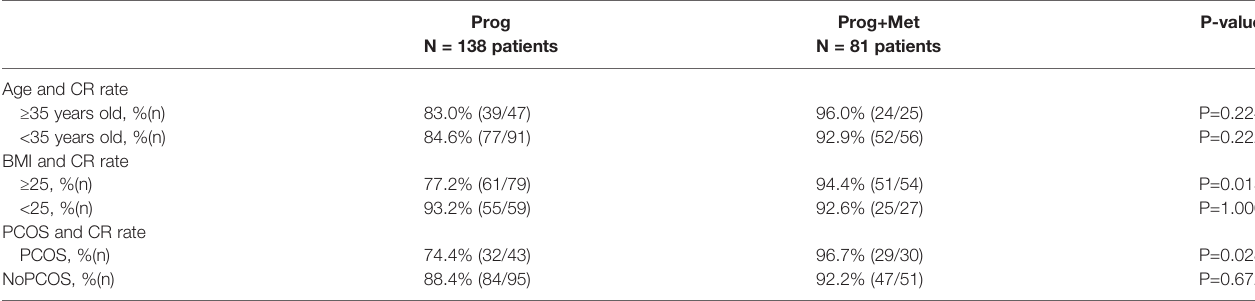
TABLE 4 | Comparison of treatment responses between the two groups in subgroup analyses.